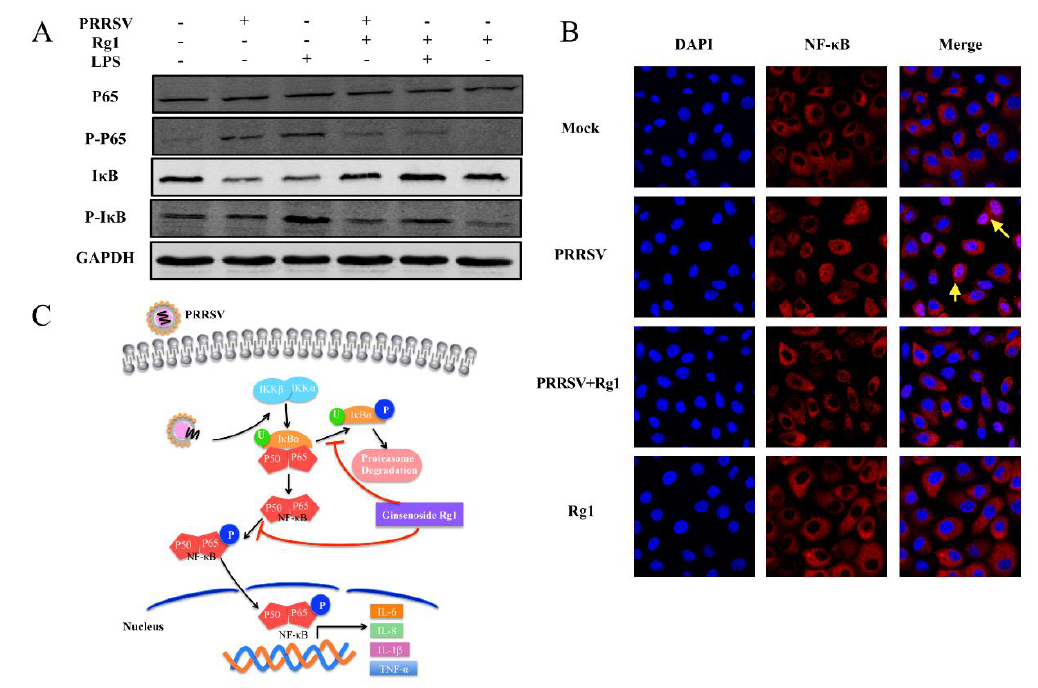
Figure 5. Rg1 inhibits the NF- κ B pathway activated by PRRSV infection. ( A ) The expression and phosphorylation level of proteins involved in NF- κ B pathway are analyzed in uninfected (Mock) and PRRSV XH-GD (0.1 MOI) infected Marc-145 cells treated with or without Rg1 (200 µ M), samples